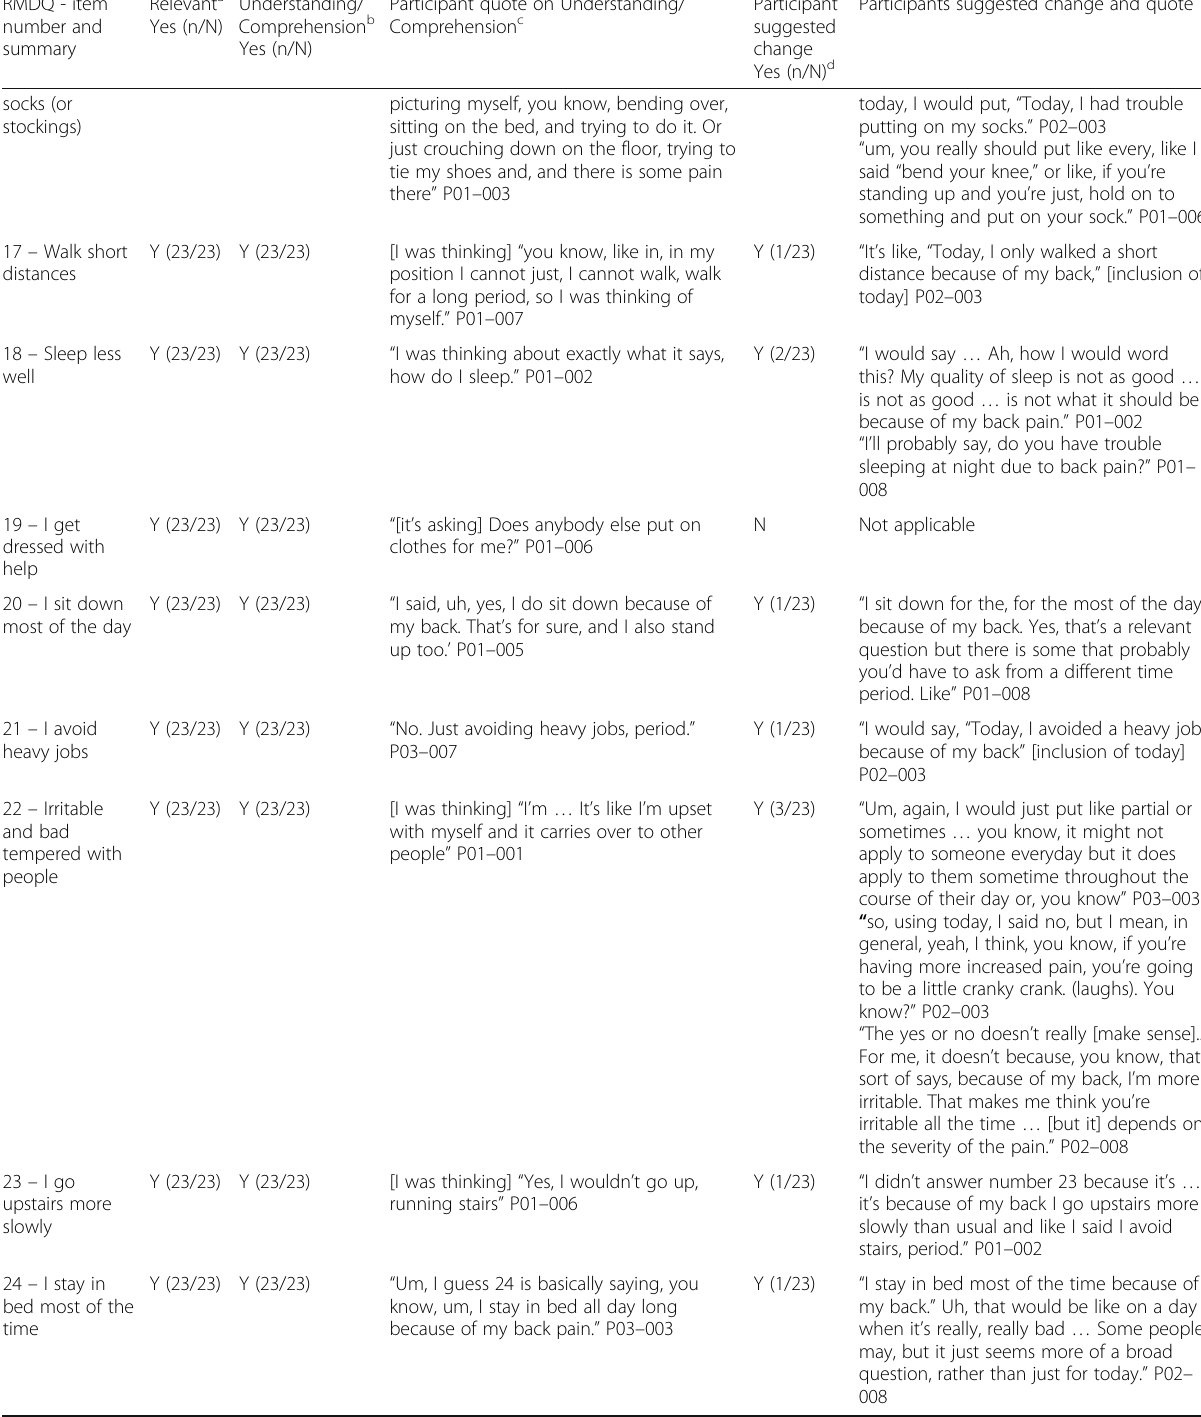
Table 4 Item relevance and participants ’ suggested edits